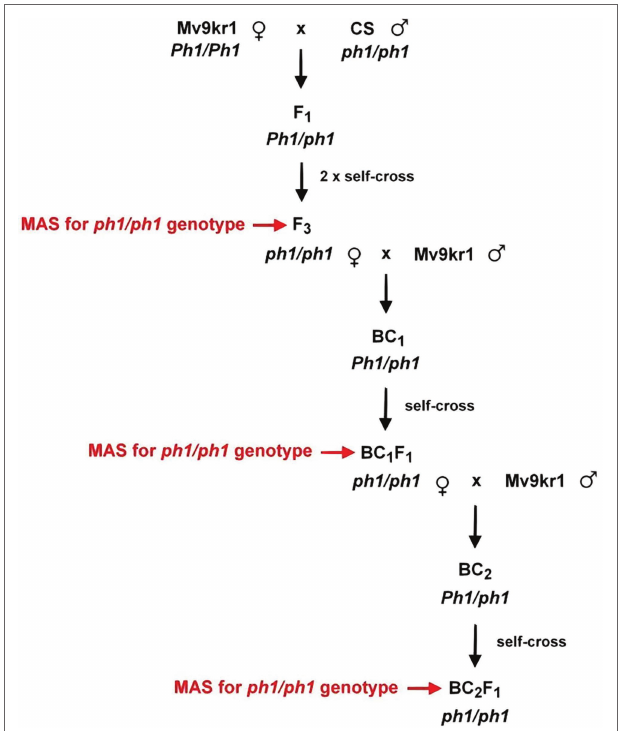
FIGURE 1 | Crossing scheme for development of the Mv9kr1 ph1b mutant (K and N)